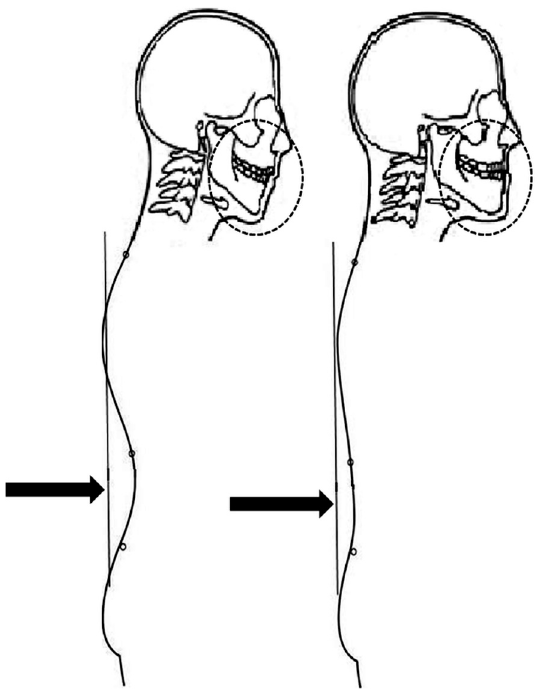
Figure 1 - Correlation between craniofacil parameters and back shape profiles: patients with distal and vertical craniofacial patterns present higher than normal upper thoracic, lumbar-lordotic, and pelvic angles; patients with mesial and horizontal craniofacial pattern present smaller than normal upper thoracic, lumbar-lordotic, and pelvic angles. Figure modified from Lippold et al.